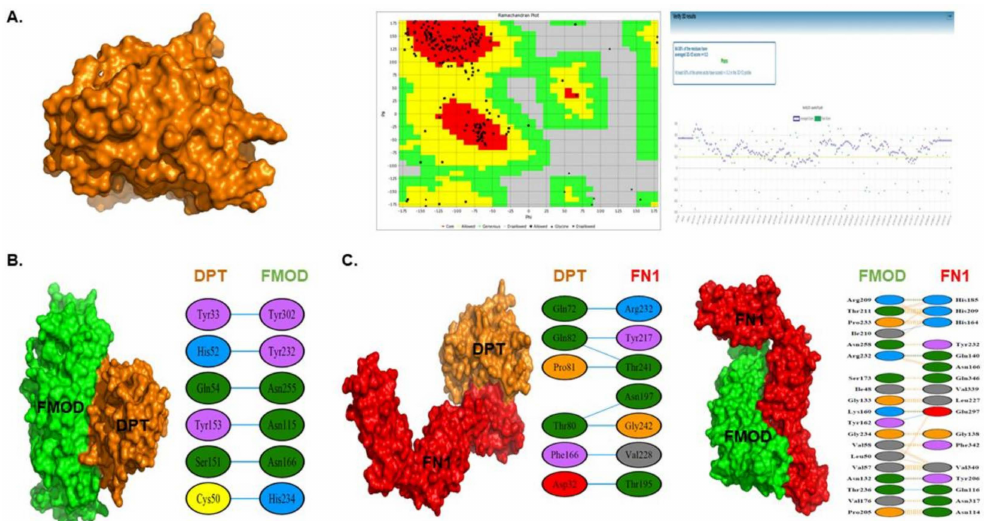
Figure 7. In silico structure prediction and validation of DPT. ( A ) A 3D structure of DPT was predicted by protein modeling servers (e.g., SPARKX) and validated by in silico tools and web-servers. Ramachandran plot analysis of the residues present in DPT and validation of modeled structure by Verify 3D web-server are shown. ( B ) The protein-protein interaction performed by PatchDock and FireDock web servers, and schematic 2-D representations of protein-protein complexes by Ligplot for DPT-FMOD. ( C ) DPT-FN and